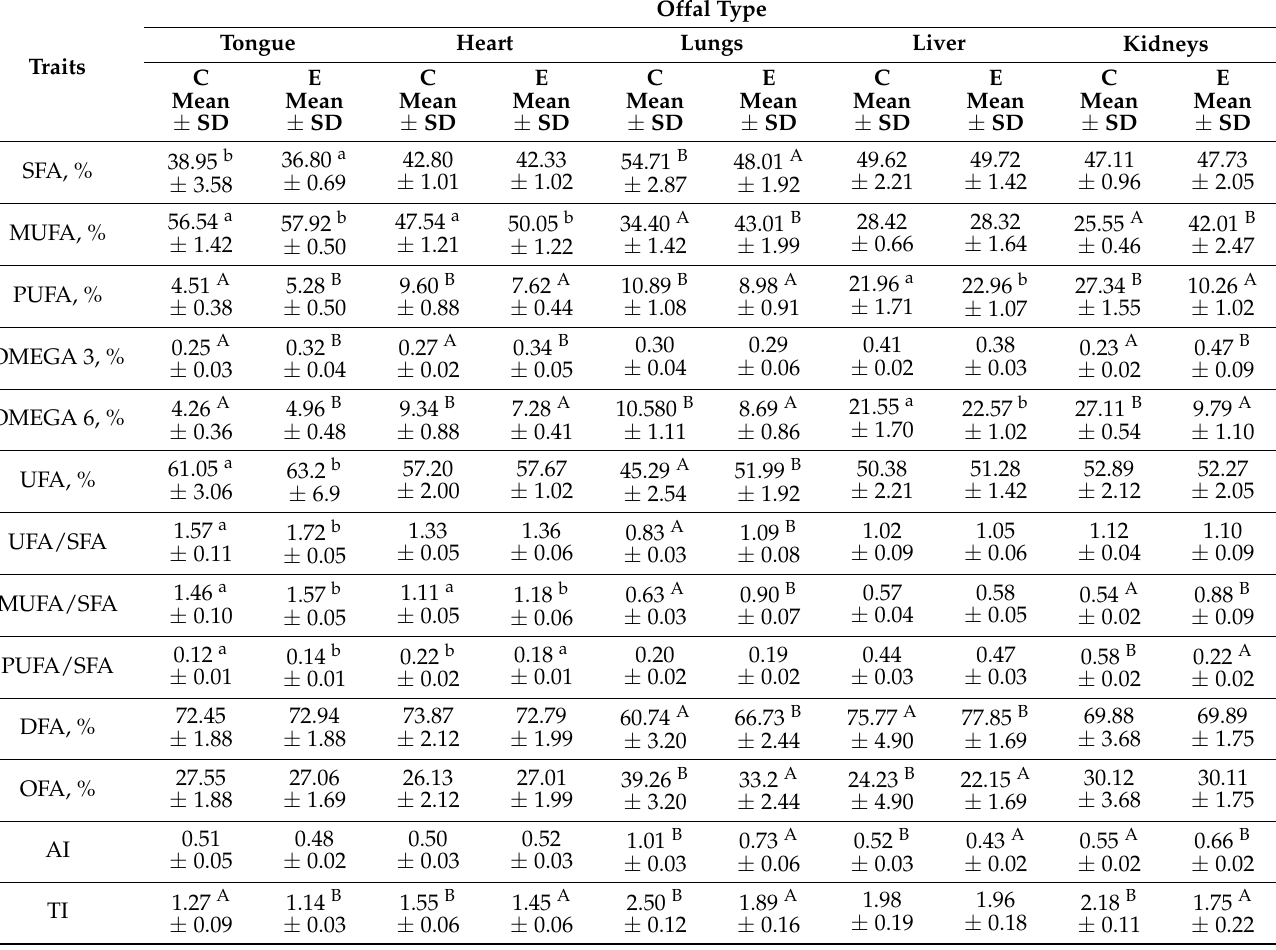
Table 7. Percentage of different groups of fatty acids, their ratios and dietary indexes of the